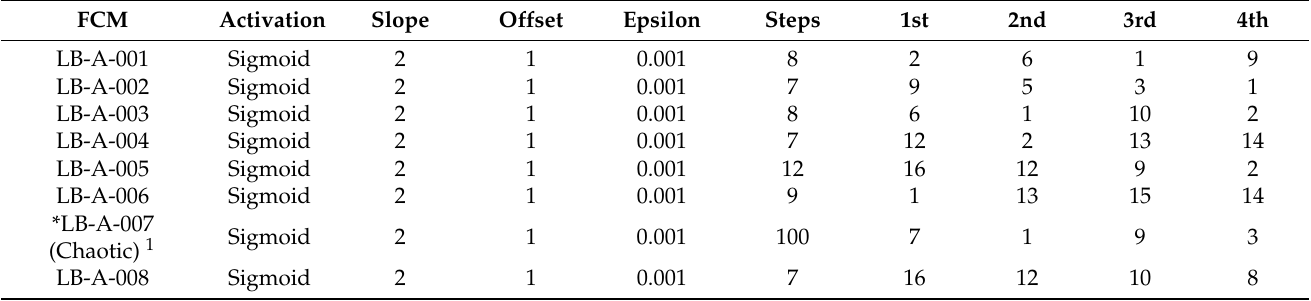
Table 9. Map outputs from autogenerated weight